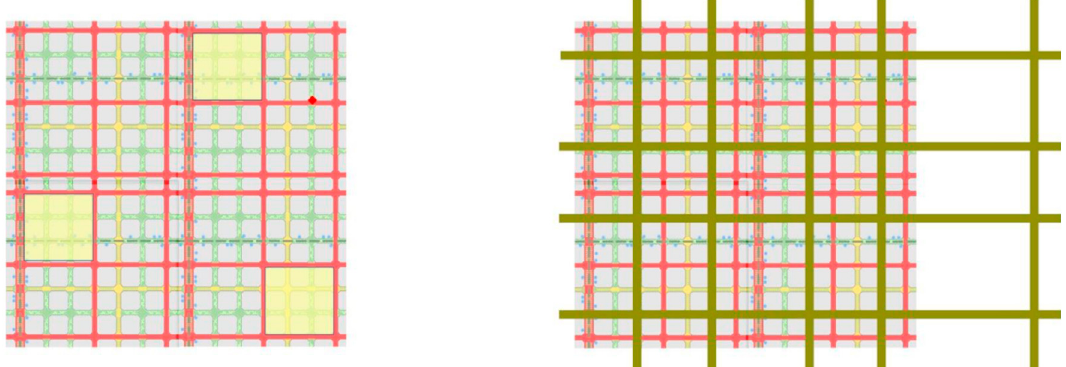
Figure 10. Diagram showing the change of approach of the Barcelona City Council. From a strategy based on local actions in self-contained superblocks (in light yellow) affecting a portion of a neighborhood, to an implementation through continuous district or city-scale green axes (thick green lines). Source: Ajuntament de Barcelona [81].